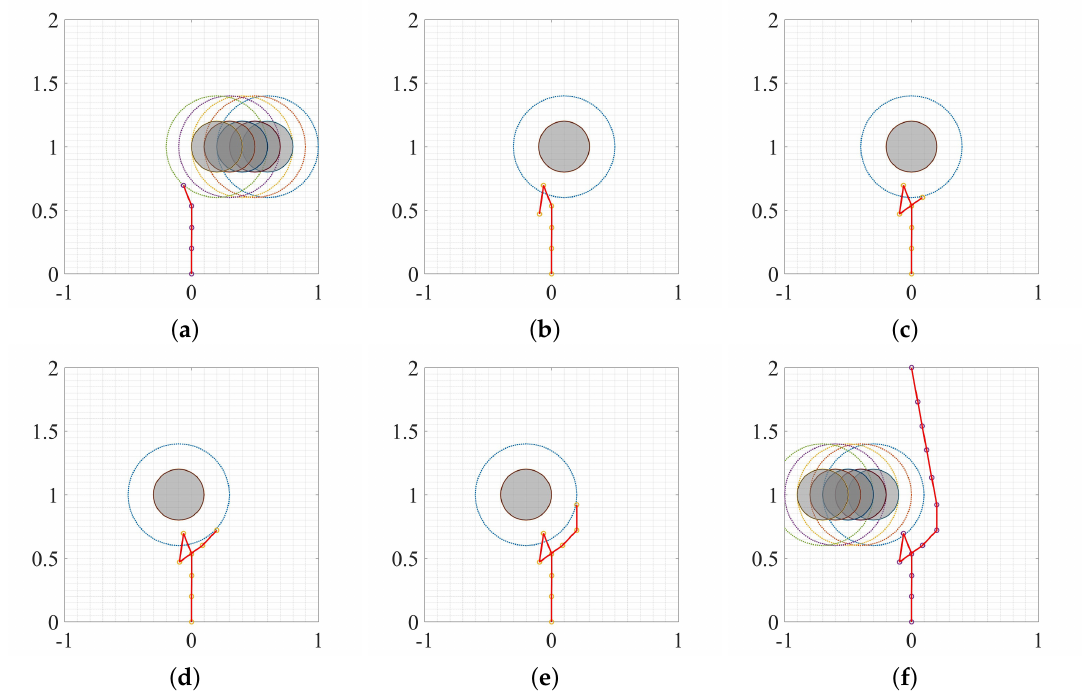
Figure 7. The robot uses the DAPF approach to avoid the slow moving obstacle: ( a ) shows the robot is before obstacle avoidance; ( b – e ) show that the robot is avoiding the obstacle, and ( f ) shows that the robot finishes obstacle avoidance.